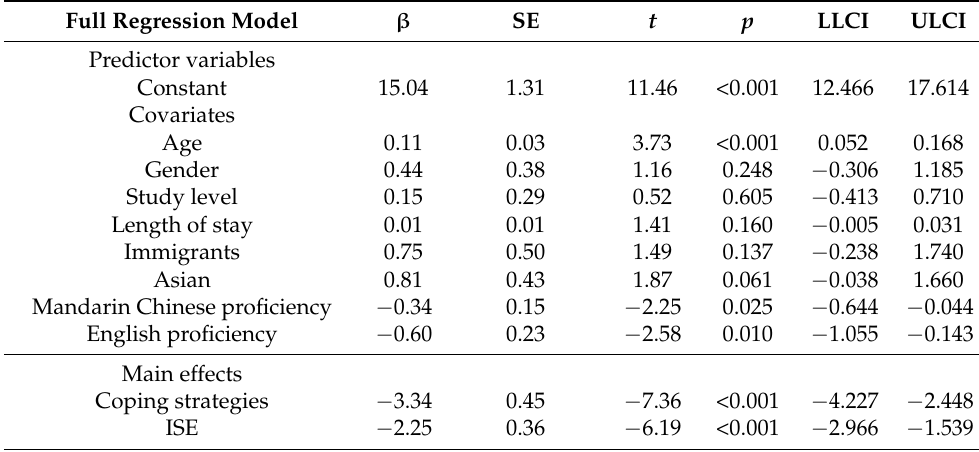
Table 7. Moderation analysis for coping strategies, ISE, and depression. Full Regression